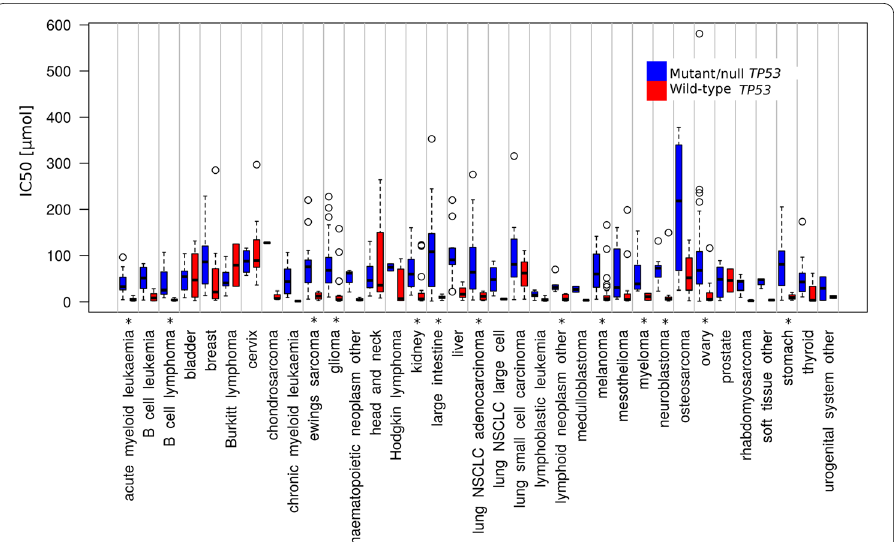
Fig. 3 IC 50 values for nutlin‑3a across cancer types. Box‑plot of IC 50 values for human cancer cell lines divided by tissue subtype. Cell lines from each tissue subtypes are divided based on their TP53 status into wild type (red) and mutant/null (blue) groups. Differences in IC 50 values between the two groups were evaluated by Mann–Whitney test; *p < 0.01. Data were obtained from Genomics of Drug Sensitivity in Cancer (dataset GDSC1; GDSC; [78]), and the IARC TP53 database (version R20, July 2019; [79]) was used for distribution according to p53